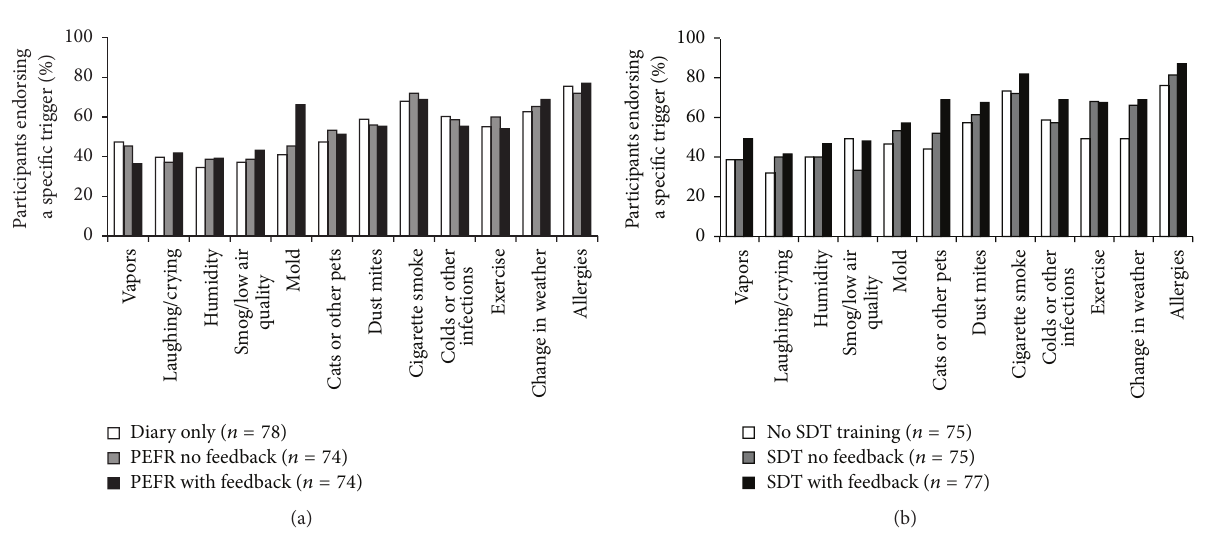
Increases in the number of reported triggers across time were also associated with reduced asthma-related quality of life for overall mini-AQLQ scores life ( 𝑡(415) = −6.55 , 𝑝 < 0.001 ) as well as for scores for each subscale (Table